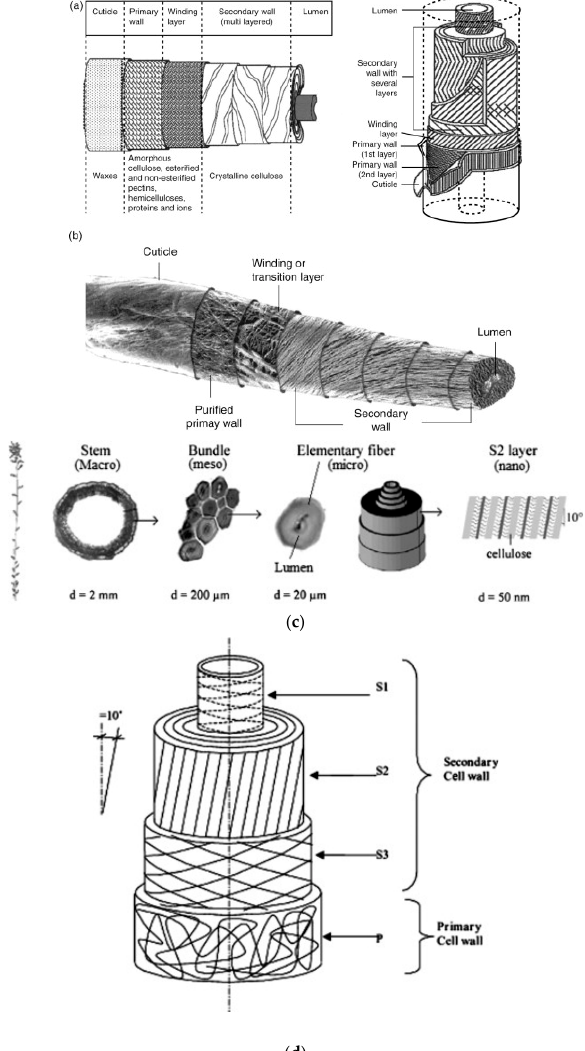
Figure 2. Schematic representation of natural fiber: ( a ) cross-section of cotton fiber. Typical compo- nents in dry, mature cotton fibers and composition of each layer, reprinted with permission from Ref. [16]. ( b ) Morphological model of cotton fiber, reprinted with permission from Ref. [16]. ( c ) Flax structure, reprinted with permission from Ref. [18]. ( d ) The micro-structure of a flax fiber cell, re- printed with permission from Ref. [19].